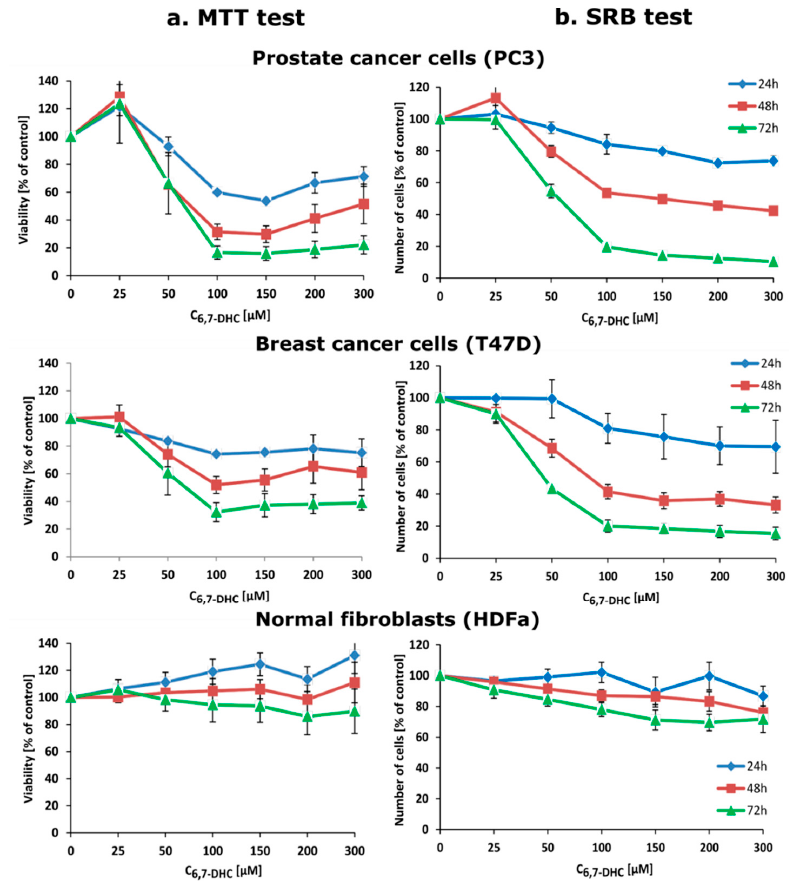
Figure 8. Selective decrease in ( a ) viability and ( b ) number of cancer cells but not normal fibroblasts under the action of 6,7-dihydroxycoumarin, measured by MTT and SRB tests, respectively. The viability and number of cells are shown as mean value ± standard error.